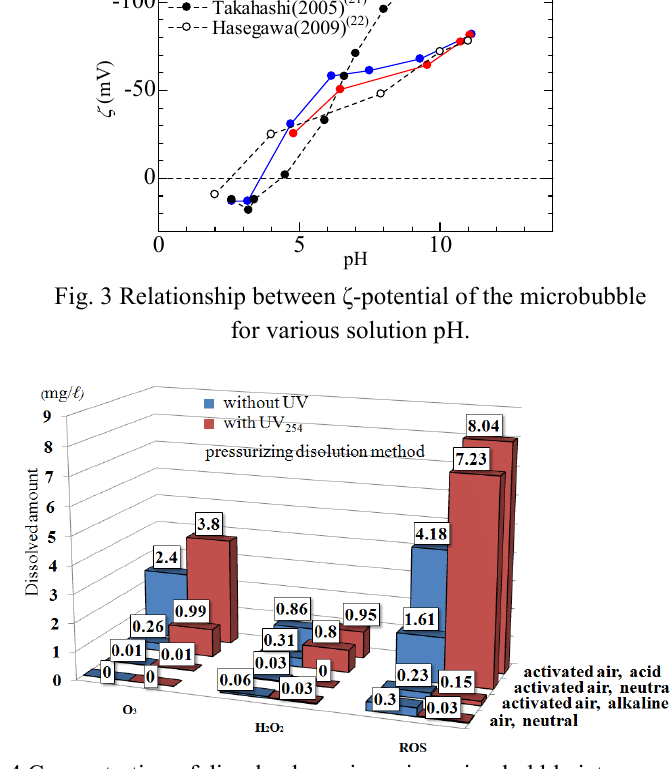
Fig. 4 Concentration of dissolved species using microbubble jet generated by pressurizing dissolution method with or without UV